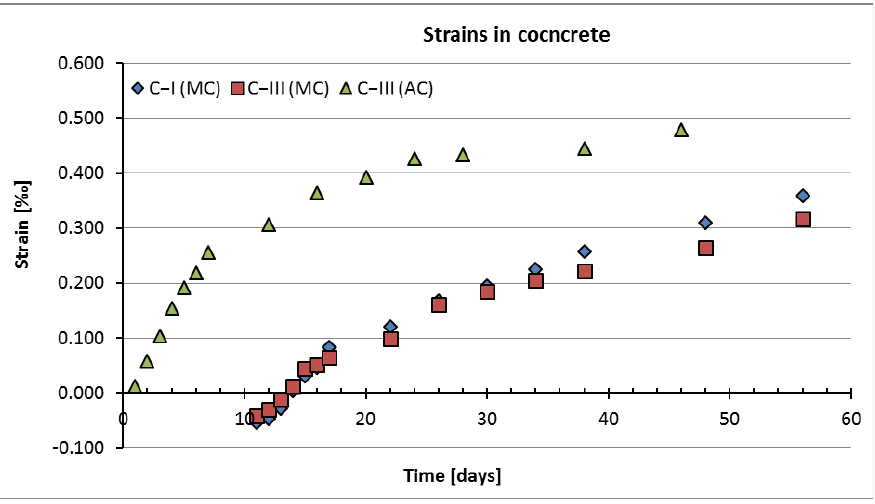
Figure 3. The result of the strain test of specimens from series C − I (MC), C − III (MC), and C − III (AC).